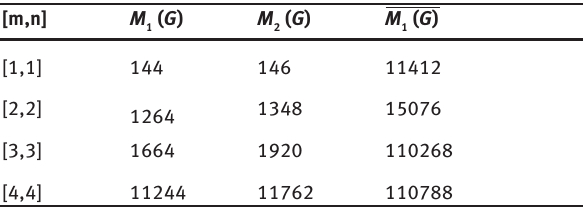
Table 3 : A comparison of Zagreb indices and coincides for Si C -III[n,m]. 2 3